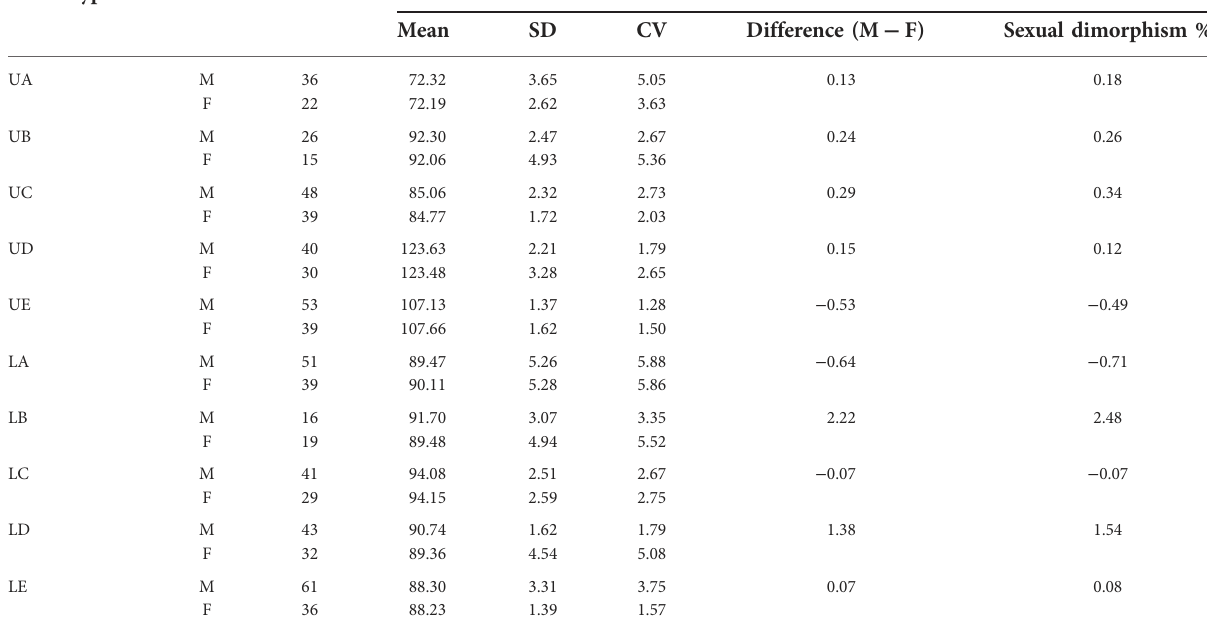
TABLE 7 Crown index and sexual dimorphism of the total sample. Tooth